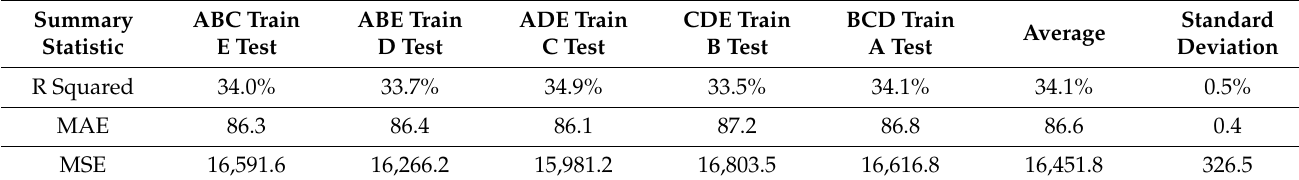
Table 5. Best RA Model tested on all folds.